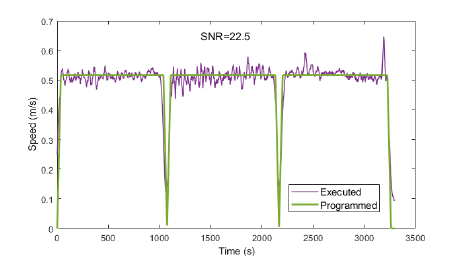
Figure 9. Trapezoidal speed profile programmed and executed.